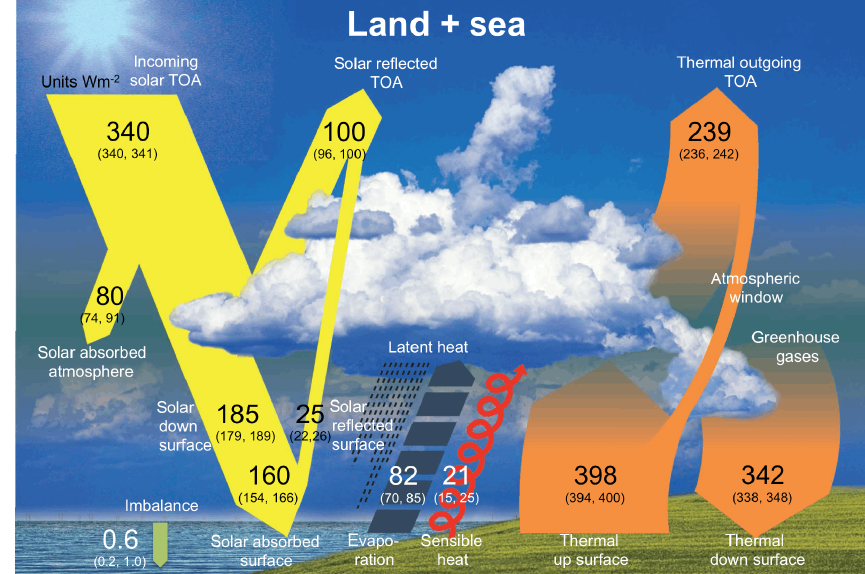
Figure 4. Schematic diagram of the global mean energy balance of the Earth. Numbers indicate best estimates for the magnitudes of the globally averaged energy balance components (Wm − 2 ) together with their uncertainty ranges in parentheses, representing present-day climate conditions at the beginning of the 21st century. Top-of-atmosphere fluxes are determined from the CERES satellite observations. Surface radiative flux estimates are derived from the CMIP5 model bias structure with respect to GEBA and BSRN observations as outlined in Wild et al. (2013, 2015). Adapted from Wild et al.